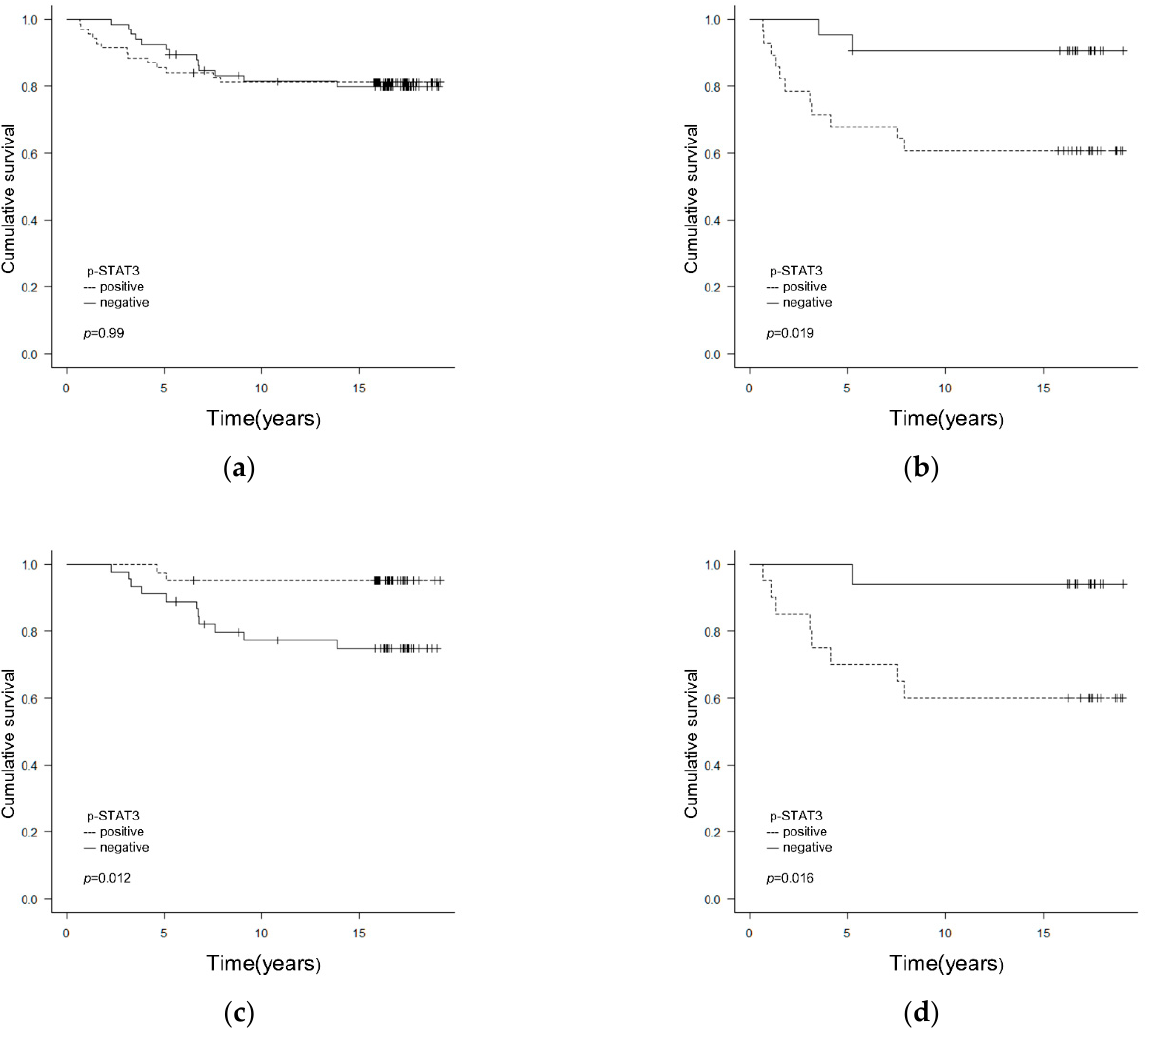
Figure 2. ( a ) Correlations between p-STAT3 expression and clinicopathological/biological factors affecting RFS in all cases. p-STAT3 expression was not linked to RFS in any of the 135 cases ( p = 0.99). ( b ) Correlations between p-STAT3 expression and clinicopathological/biological factors affecting RFS in ER( − ) cases. In ER( − ) cases (n = 49), the RFS rate was lower in the p-STAT3(+) than in the p-STAT3( − ) group ( p = 0.019). ( c ) Correlations between p-STAT3 expression and clinicopathologi- cal/biological factors affecting RFS in ER(+) cases. In ER(+) cases (n = 86), the RFS rate was higher in the p-STAT3( − ) than in the p-STAT3(+) group ( p = 0.012). ( d ) Correlations between p-STAT3 expression and clinicopathological/biological factors affecting RFS in TNBC cases (n = 37). The RFS rate was lower in the p-STAT3(+) than in the p-STAT3( − ) group ( p = 0.016). In the RFS curves in ( b – d ), p < 0.025 was considered significant. p-STAT3, phosphorylated-STAT3; RFS, relapse-free survival; ER, estrogen receptor; TNBC, triple-negative breast cancer.